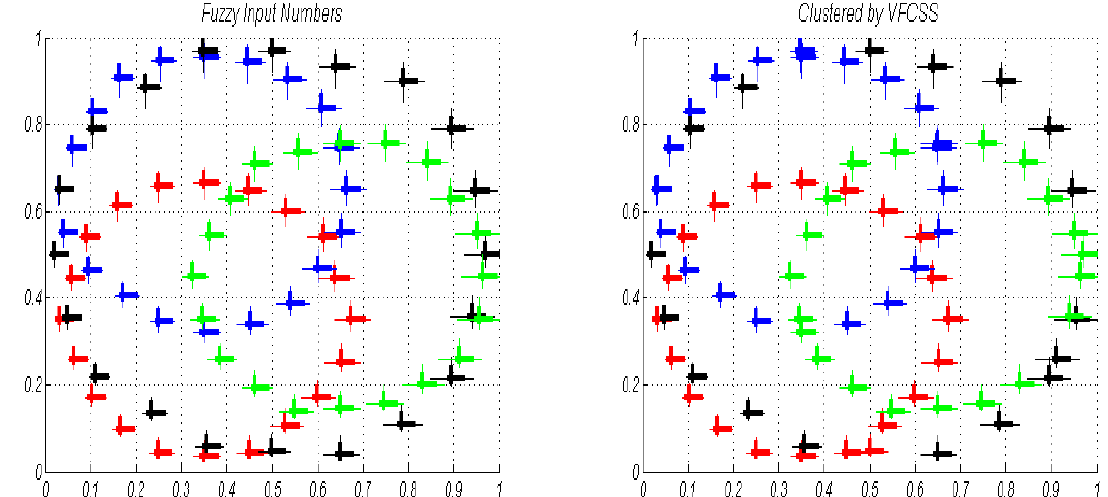
Figure 4. Proposed VFCSS clustering over input non-symmetric LR-type fuzzy numbers include four interference classes red, blue, black and green with (20,20,20,20) members, (first step of state 2).